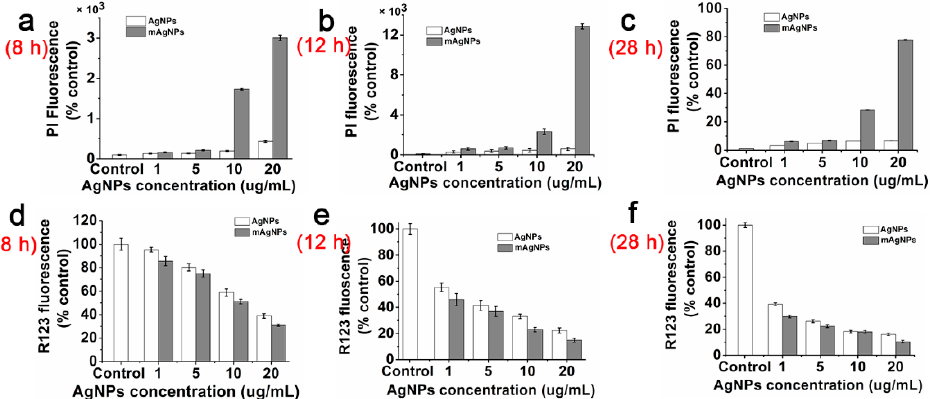
Figure 4. Effects of different levels (0, 1, 5, 10, and 20 ug/mL) of AgNPs and mAgNPs on ∆Ψ m values and membrane integrity in E. coli cells at 6 h, 12 h, and 28 h. ∆Ψ m values of E. coli at 6 h ( a ), 12 h ( b ), and 28 h ( c ); cell membrane integrity of E. coli at 6 h ( d ), 12 h ( e ), and 28 h ( f ).